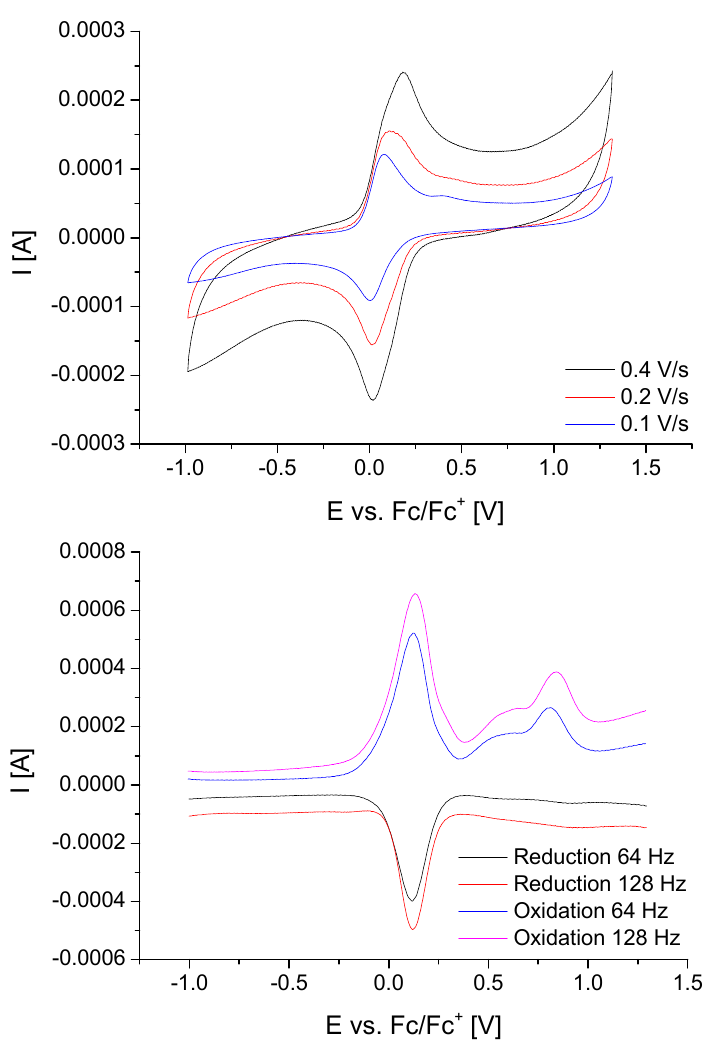
Figure 6. Cyclovoltammogram of 1k (top) and square-wave voltammogram of 2k (bottom) in acetonitrile/TBABF 4 .